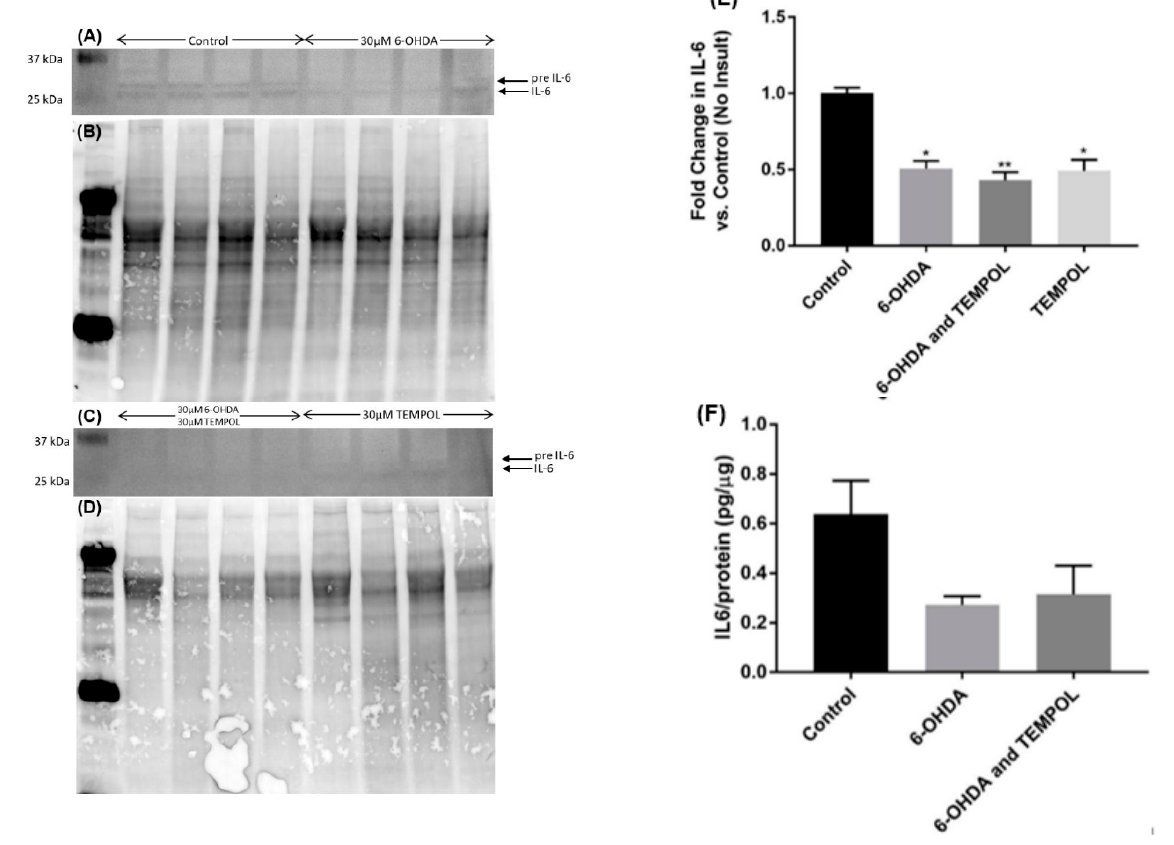
Figure 9. Assessment of IL-6 protein expression by Western blotting and ELISA in cultured SH-SY5Y dopaminergic cells after treatment with 6-OHDA ± TEMPOL. Levels of IL-6 protein expression were determined in SH-SY5Y dopaminergic cells 24 h after treatment with 30 μ M 6-OHDA ± 30 μ M TEMPOL by Western blotting: panel ( A ) representative blot Lane 1 molecular weight standard; Lanes 2–5 vehicle control; Lanes 6–9; cells + 6-OHDA and panel ( C ) representative blot Lane 1: molecular weight standard; Lanes 2–5; 30 μ M 6-OHDA + 30 μ M TEMPOL; Lanes 6–9; cells + 30 μ M TEMPOL alone. Panel ( E ) corresponding densitometric analysis of protein bands with normalization to corresponding in gel total protein assessed in the same SDS-PAGE blot (in gel protein staining shown in panels ( B , D ) prior to transfer step). Different to vehicle-treated control; * p ≤ 0.001, ** p ≤ 0.0001. Panel ( F ) Levels of